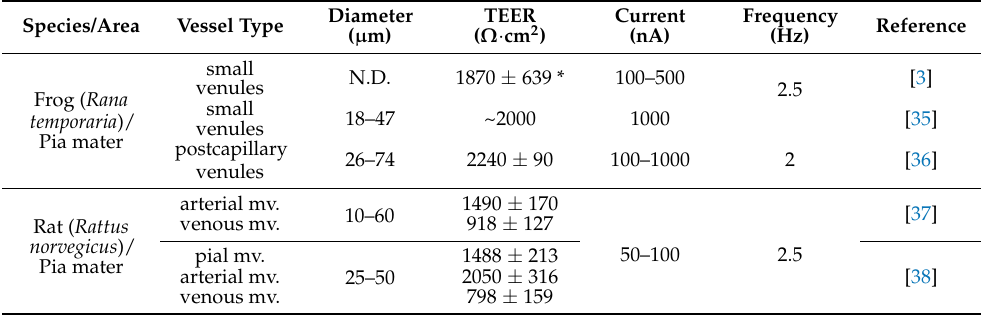
Table 1. Electrical resistivity (TEER) of brain surface microvessels. All TEER values are means ± SEM, except for the one marked by an asterisk (*), which is the mean ±